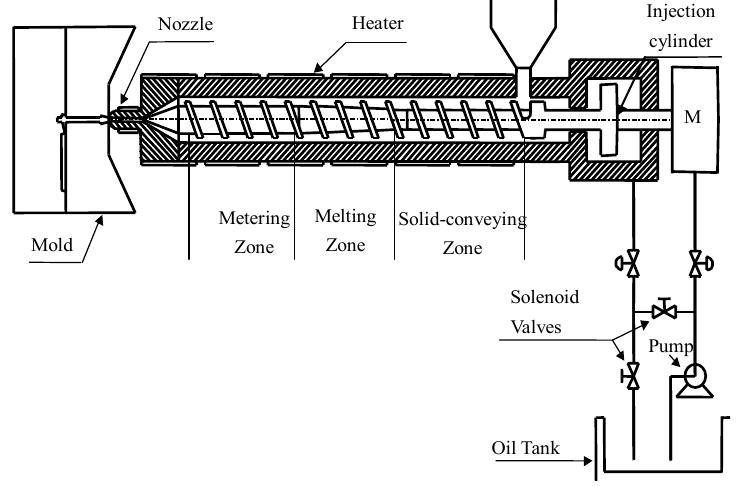
Figure 6. A simplified schematic diagram of the injection molding machine.